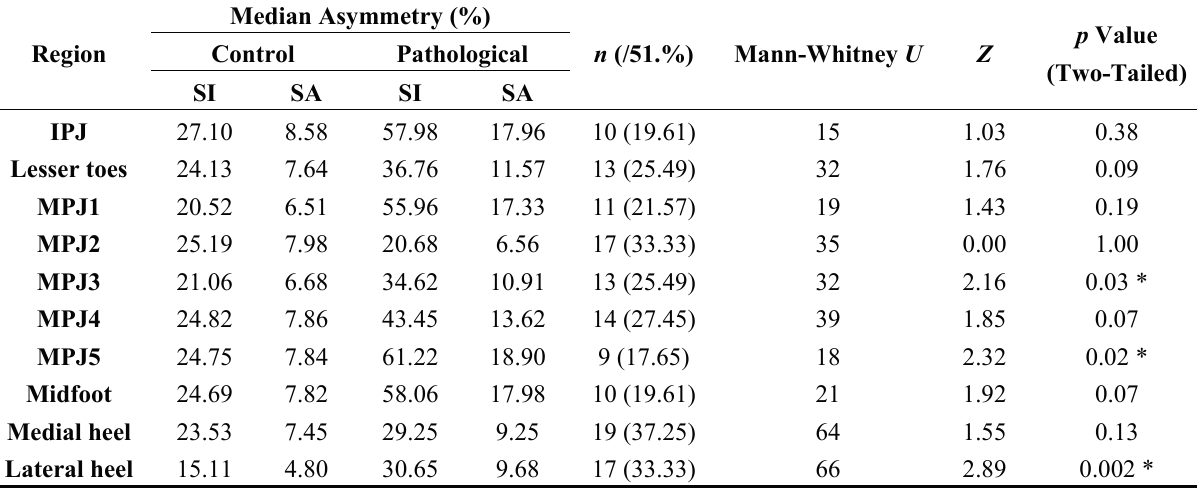
Table 4. Assessment of median asymmetry percentage in control and pathological groups taking into account intra-limb variability for Mann-Whitney U tests per region of interest. Significant results are indicated with an asterisk (*). Median Asymmetry